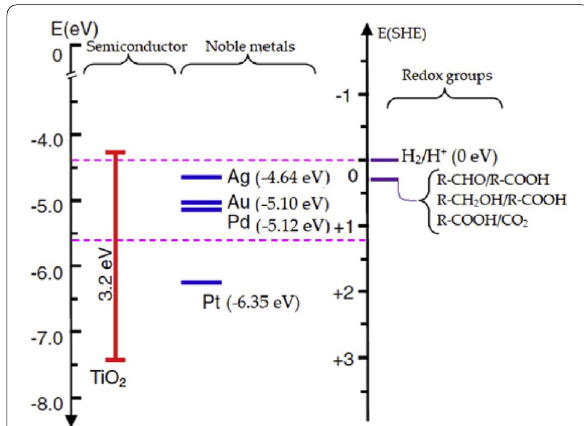
Fig. 4 Energy band positions, the work functions of the noble metals, and the electrochemical potentials of the redox couples involved. Reprinted with permission from Ramis et al. [40] (Copyright 2020 Elsevier)